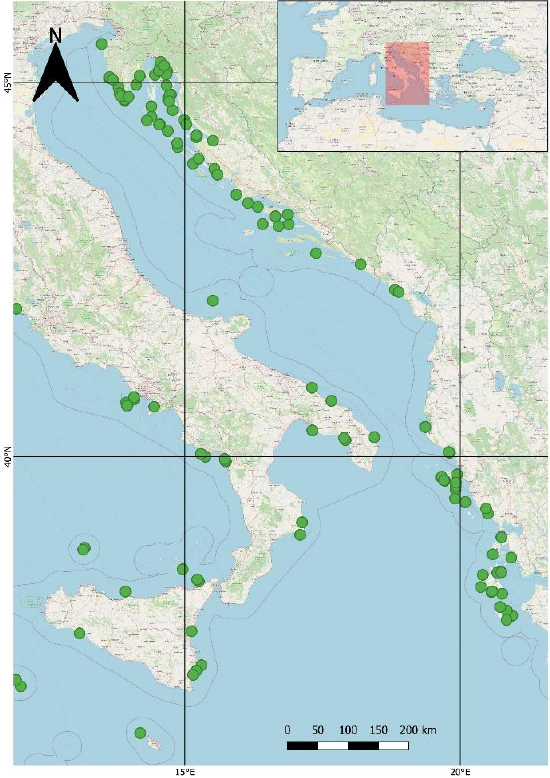
Figure 2. Records of Gobius incognitus in the Adriatic Sea and Ionian Sea.